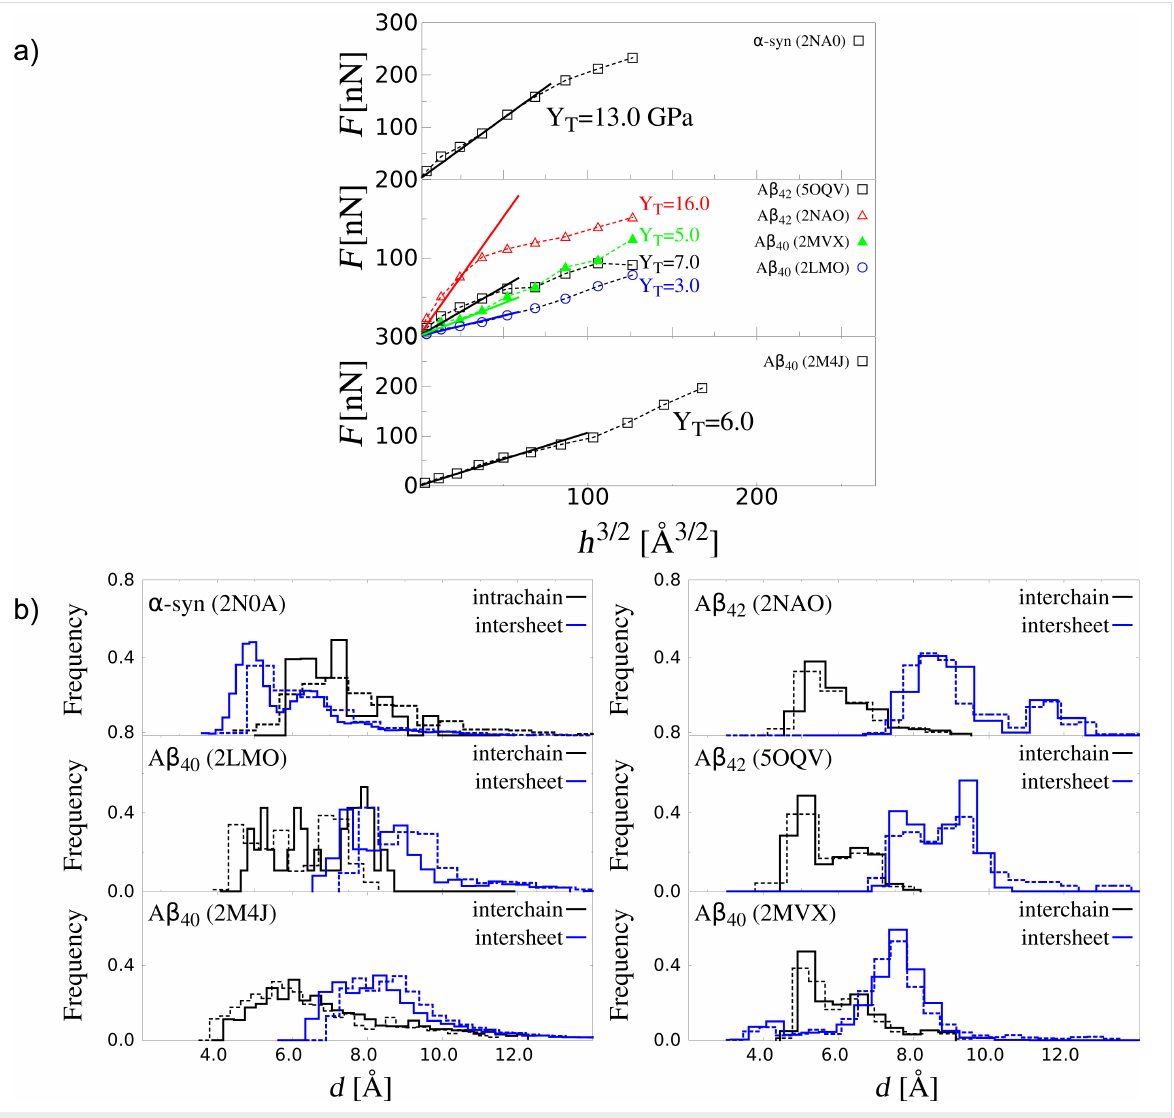
Figure 6: Nanoindentation deformation results for different biological fibrils. (a) Force as a function of the indentation depth ( h ) for α -syn, three A β 40 , and two A β 42 fibrils. Square symbols refer to v ind = 0.005 Å/ τ and R ind = 10 nm. The error bars are the same as the symbol size and they are based on 50 independent simulations for each system. The distributions are calculated for h = 0 (solid line) and h = 20 AA in the case of α -syn fibrils and A β fibrils (dashed lines). Only in the case of A β 42 with PDB ID: 2NAO the value h = 9 Å was